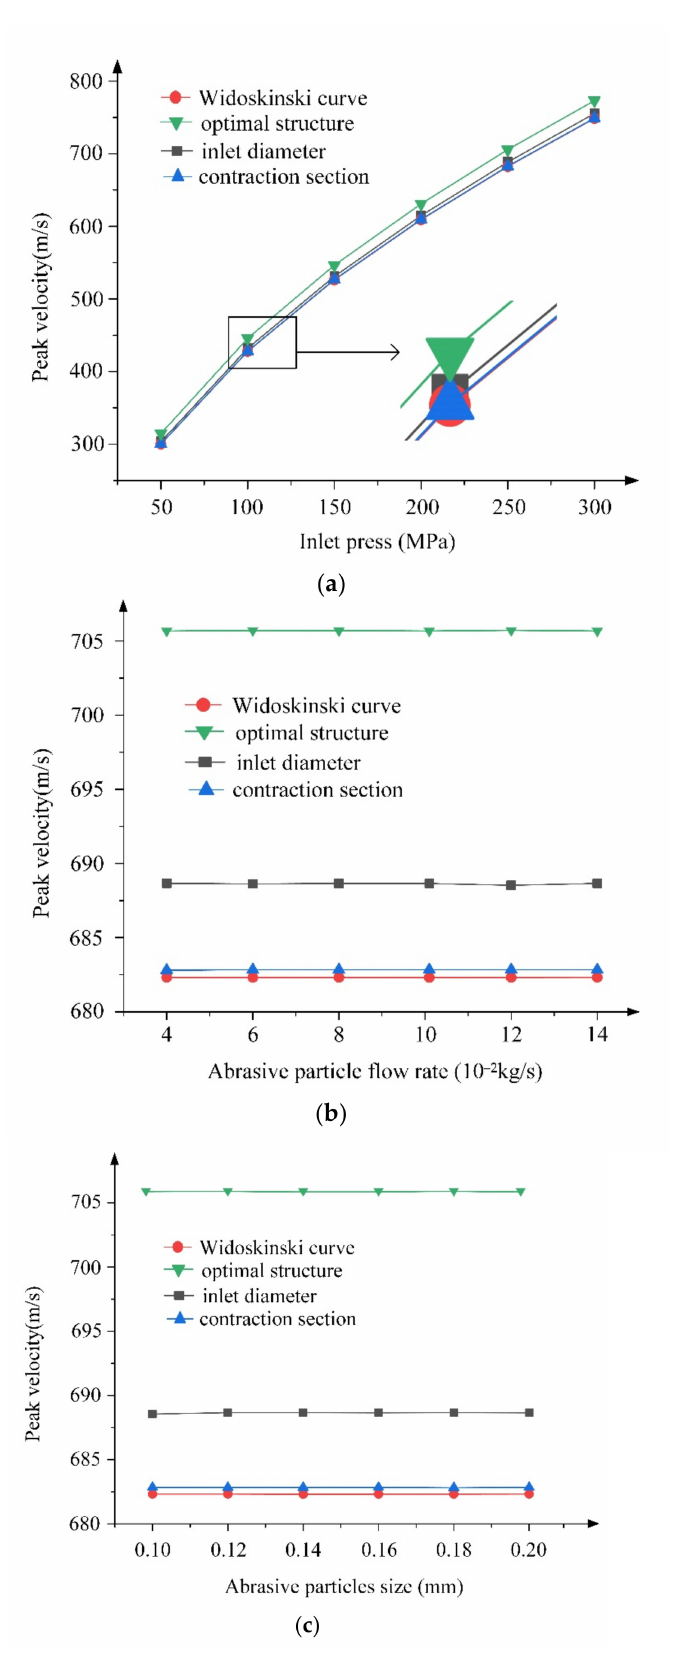
Figure 13. Operation parameter effects on the peak velocity: ( a ) Inlet pressure effects of the peak velocity; ( b ) abrasive particle flow rate effects on peak velocity; ( c ) abrasive particle size effects on peak